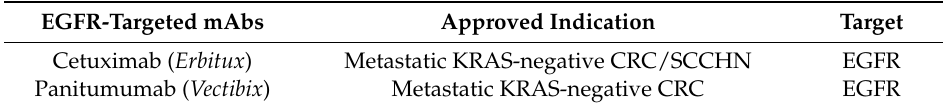
Table 2. Anti-EGFR monoclonal antibodies approved for cancer